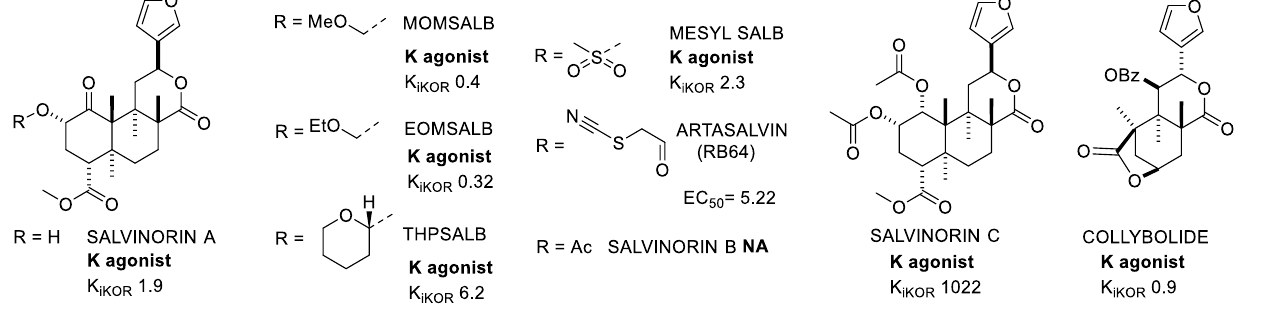
Figure 4. Salvinorin A and selected analogues and derivatives. K i values are also shown